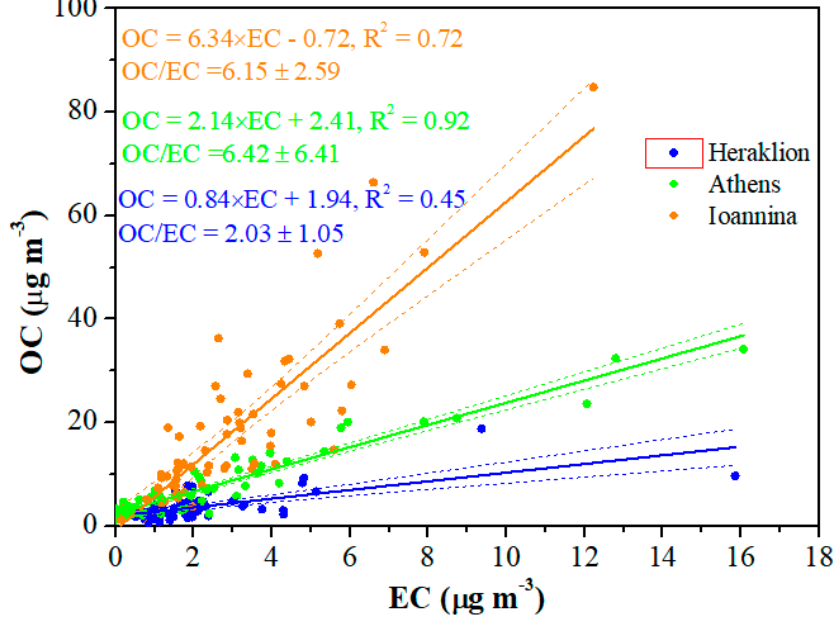
Figure 2. EC vs. OC concentrations in Heraklion, Athens, and Ioannina during the common period of measurements (January to February 2013).